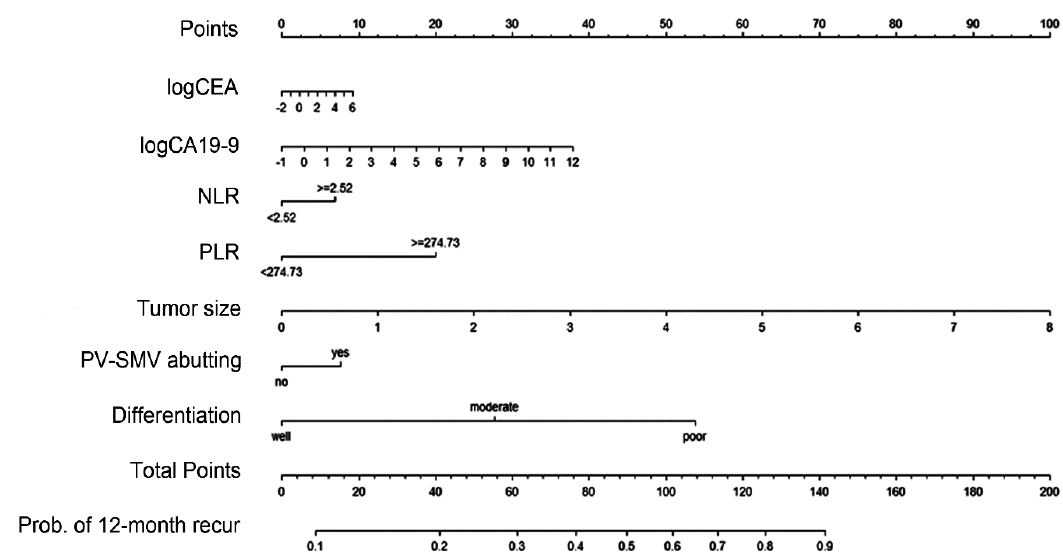
Figure 2. Nomogram for predicting early recurrence (within 12 months) after pancreatectomy using preoperative parameters in resectable pancreatic ductal adenocarcinoma. CEA: carcinoembryonic antigen; CA: carbohydrate antigen; NLR: neutrophil-lymphocyte ratio; PLR: platelet-lymphocyte ratio; PV-SMV: portal vein-superior mesenteric vein